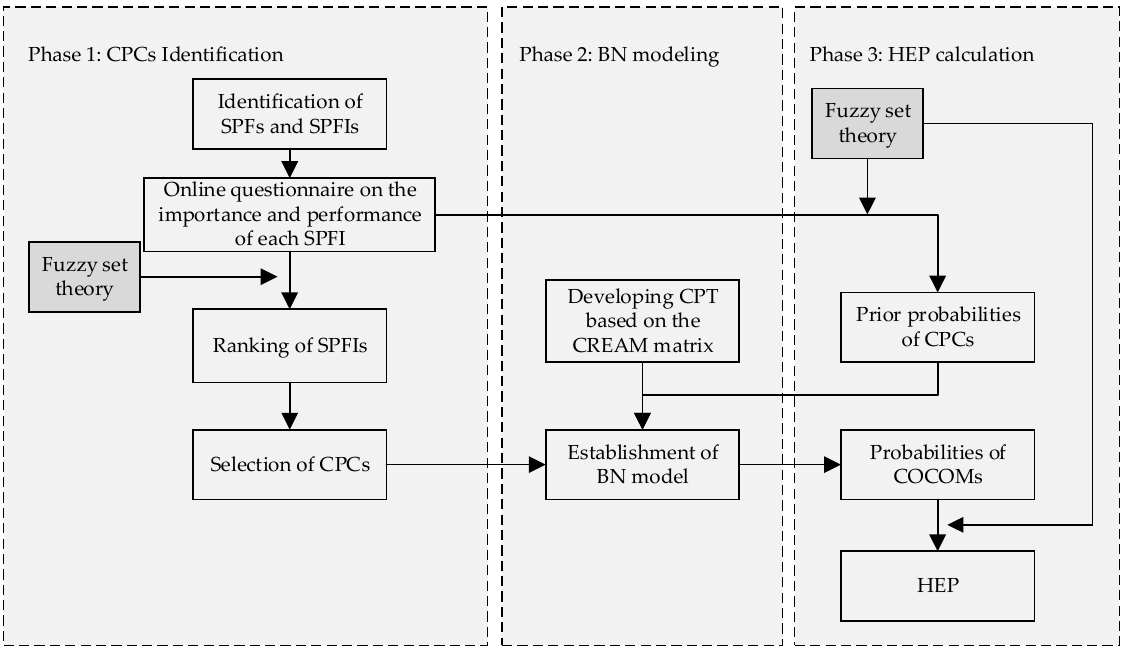
Figure 2. The framework of human error probability (HEP) assessment.